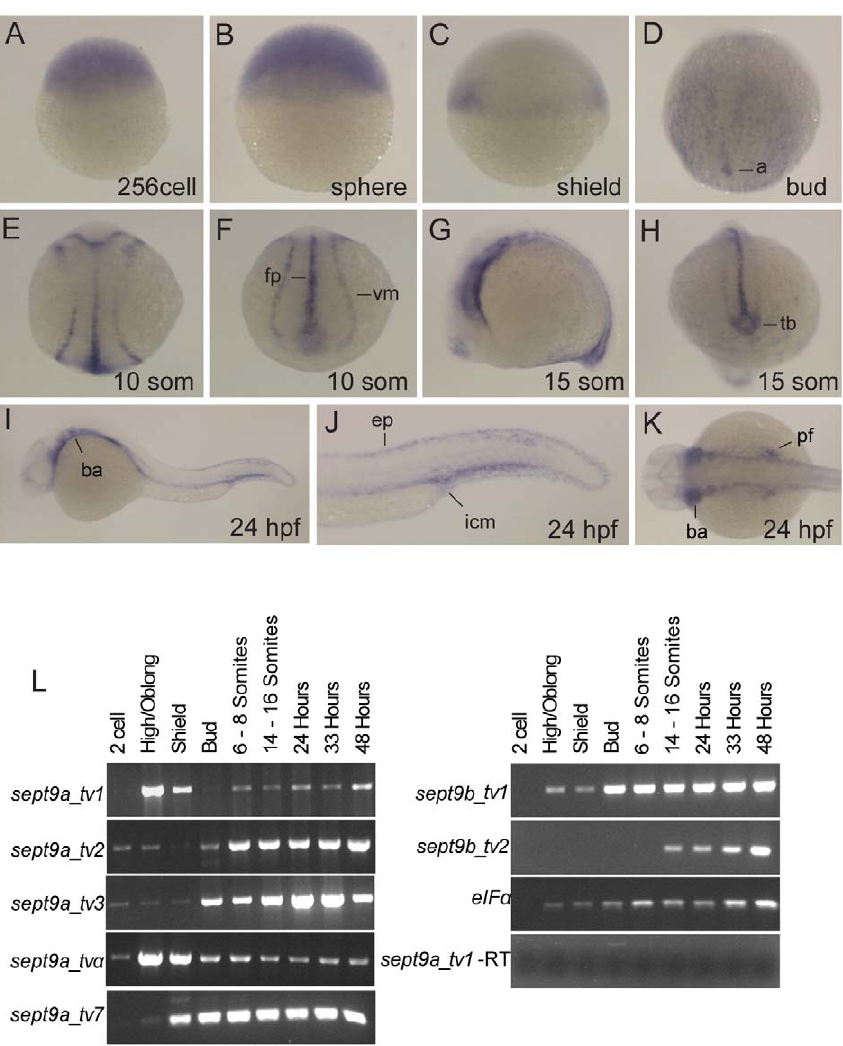
Figure 3. Expression of sept9 genes during zebrafish development. Detection of sept9 mRNA was carried out by whole-mount in situ hybridization using a probe targeted to all sept9 isoforms on staged embryos from 256 cells to 24 hpf. Images in A–C are lateral views, animal pole to top; D and E are dorsal views, anterior to top; F and H are dorsal posterior views; G, I and J are lateral views, K is a dorsal view, anterior to left. A–C : sept9 transcripts are ubiquitously expressed at early developmental states. D : At bud stage, sept9 is expressed in endoderm and axis. E–H : sept9 is expressed in the floor plate, ventral mesoderm and tail bud during segmentation. I–K : At 24 hpf, sept9 is expressed throughout the epidermis, branchial arches, pectoral fin, and in the intermediate cell mass. L : Transcript specific primers were used to detect sept9a and sept9b transcripts in various stages of development by RT-PCR. sept9a_tv 2, 3 , and a are expressed maternally. Amplification of eIF a and total RNA without addition of reverse transcriptase were used as controls. a, axis; ep, epidermis; fp, floorplate; icm, intermediate cell mass; tb, tail bud; vm, ventral